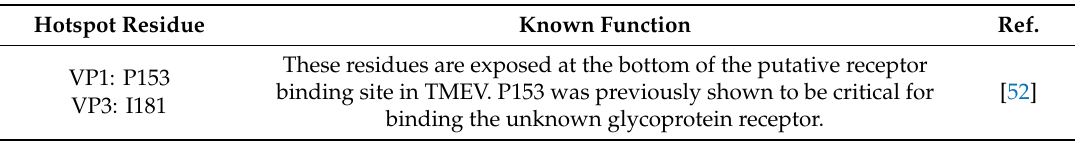
Table 5. Interprotomer hotspot residues in TMEV with previously known